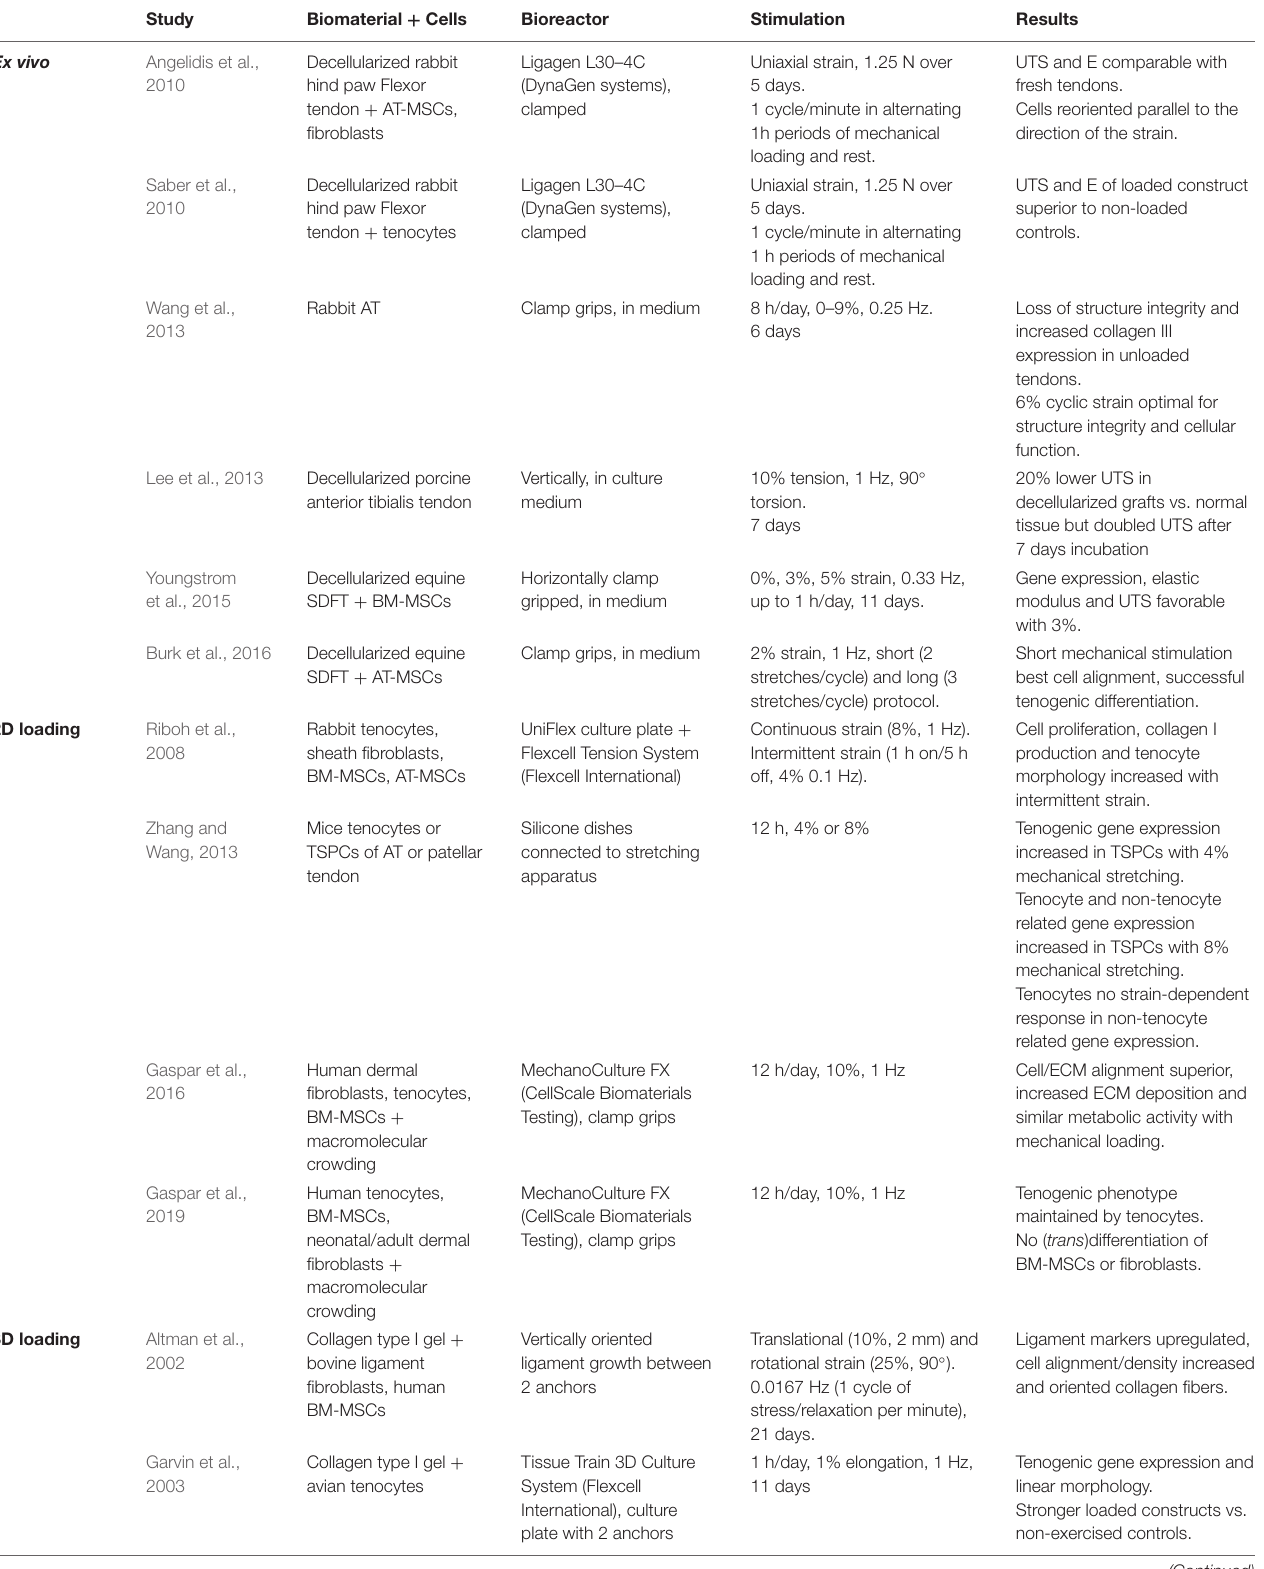
TABLE 1 | Overview of bioreactors used in tendon tissue engineering which all apply mechanical